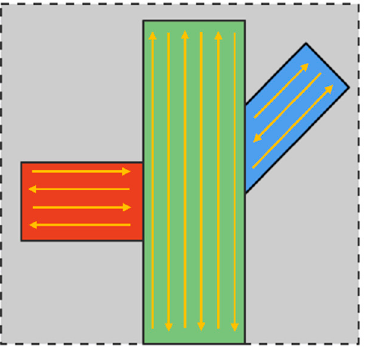
Figure 1. Single printing layer with multiple raster directions represented by the yellow arrows.